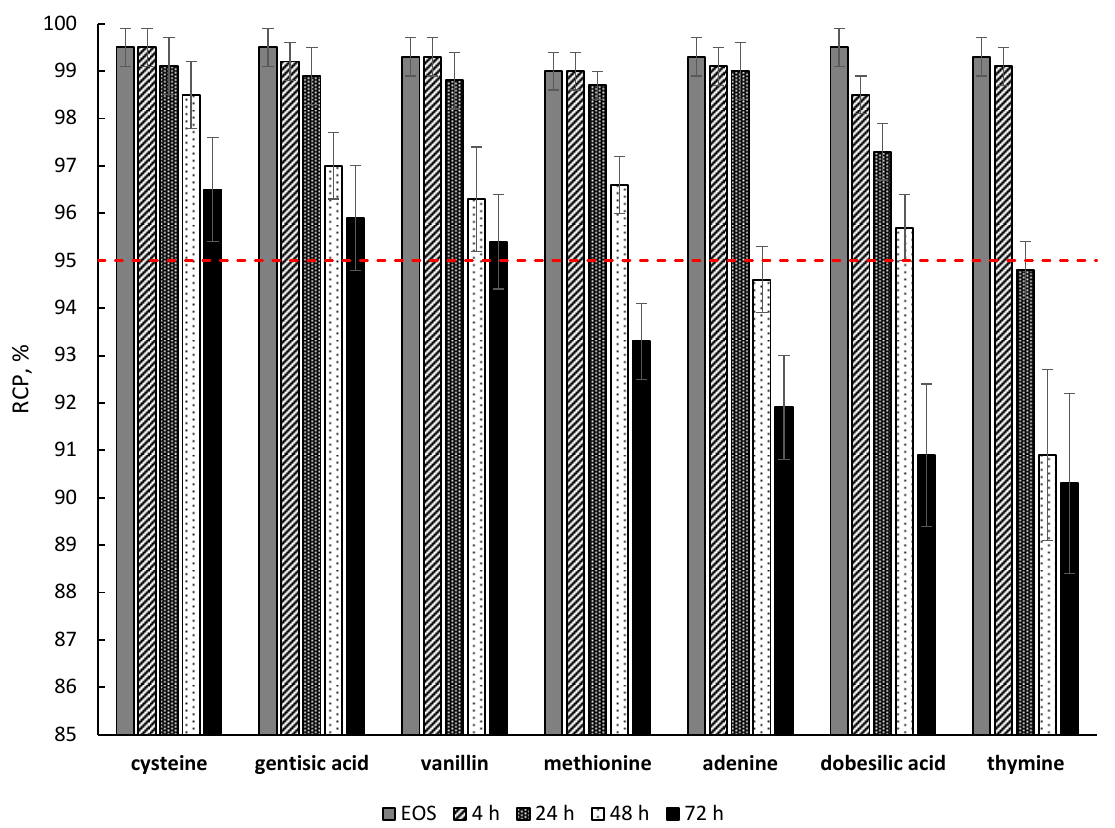
Figure 13. Influence of selected quenchers on the maintenance of [ 177 Lu]Lu-PSMA-617 radiochemical purity over time. Samples volume—1 mL, 177 Lu activity in the sample—450 MBq, pH 4.5, synthesis at 95 ◦ C for 30 min, C(Na-acetate) = 0.03 mol/L (RCP value is presented as mean ± SD, n = 3).